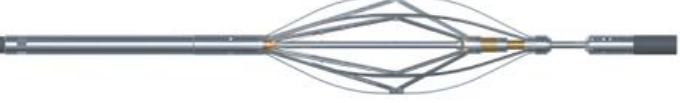
Figure 1. Schematic diagram of AORT structure.